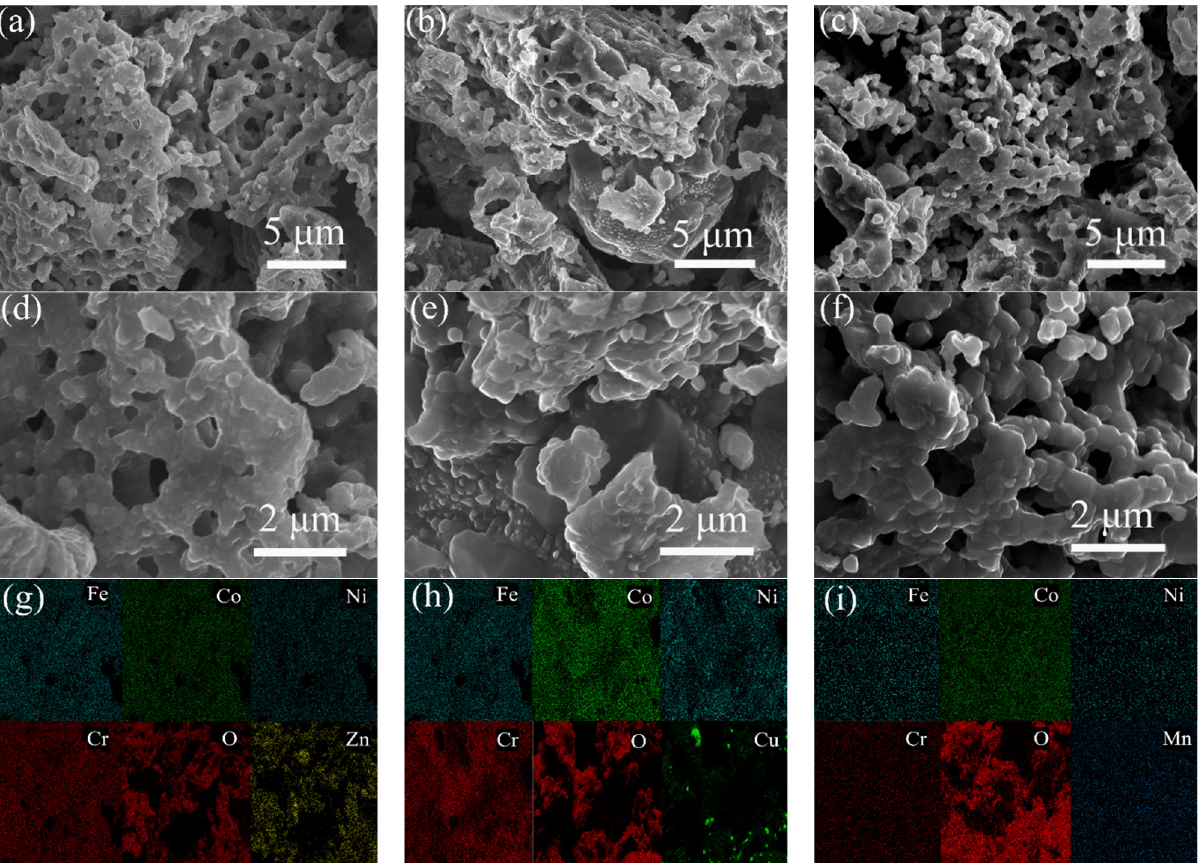
Figure 1. SEM images and EDS-mapping of ( a , d , g ) HEO − Zn, ( b , e , h ) HEO − Cu, and ( c , f , i ) HEO − Mn samples, respectively.